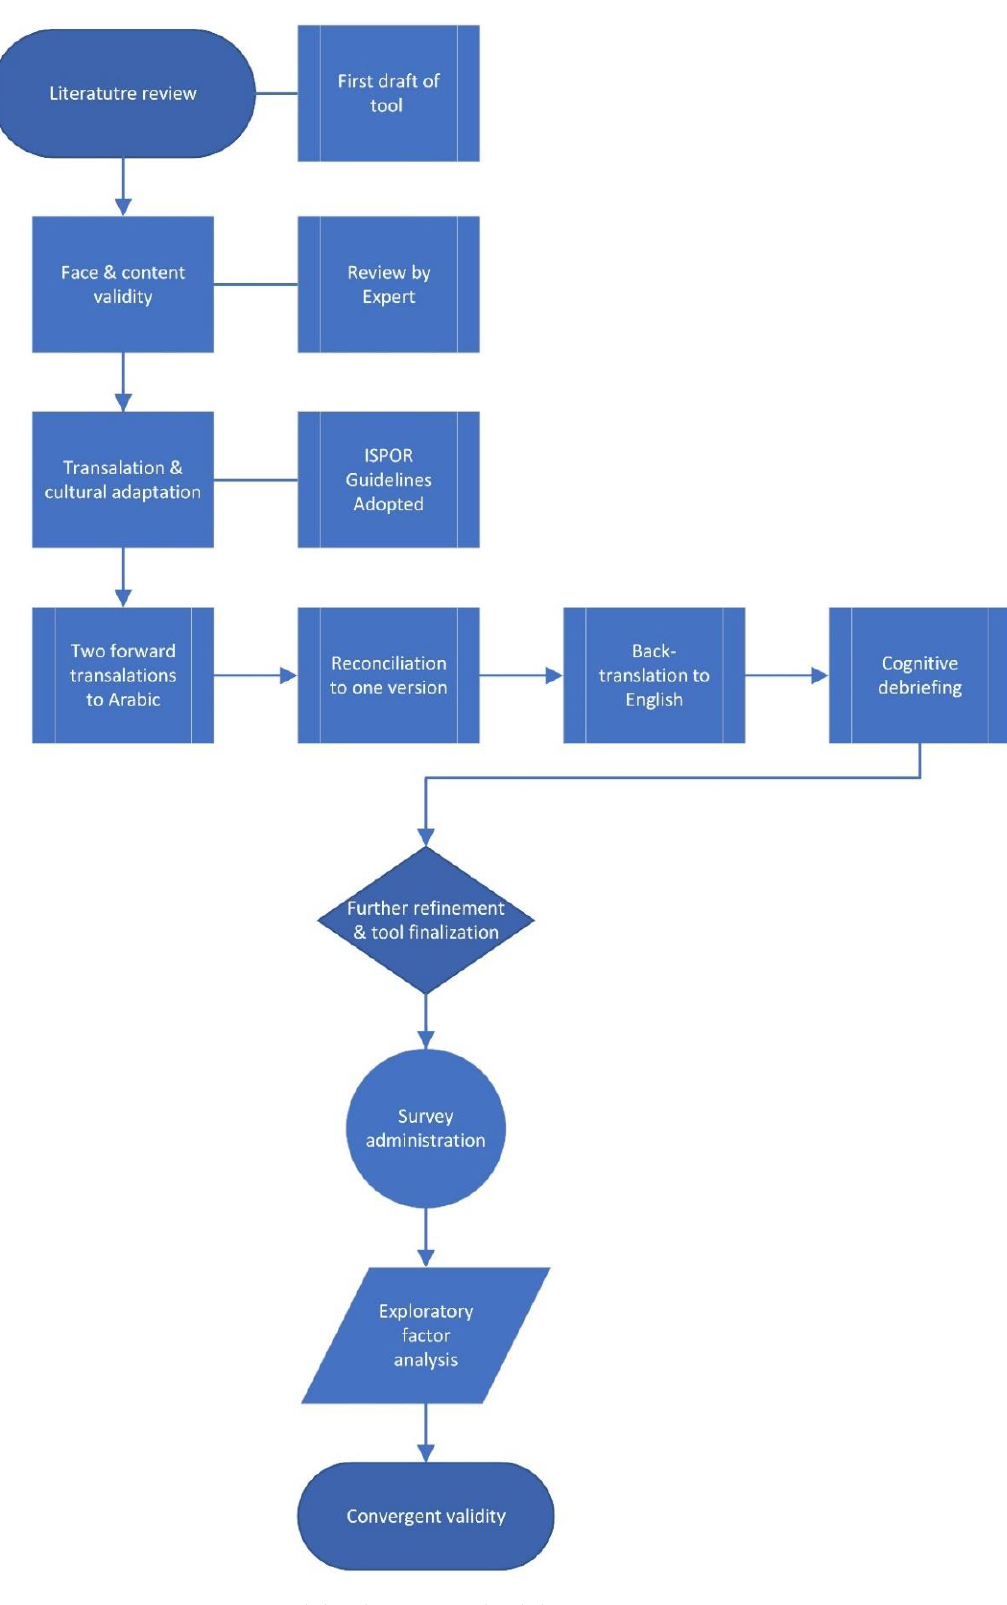
Figure 1. Tool development and validation.